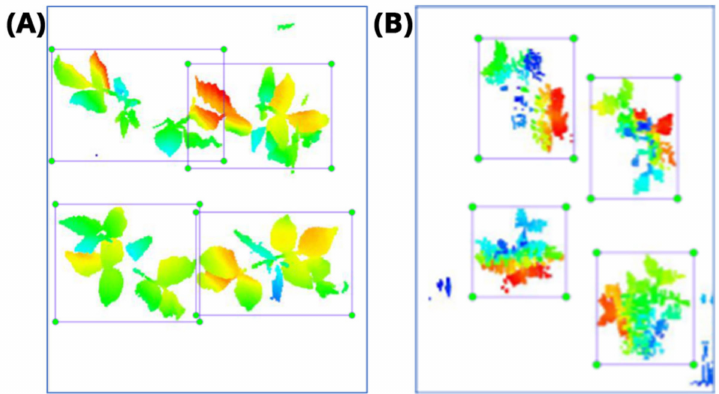
Figure 10. Samples of labeled images – mung bean ( A ), chickpea ( B ). The labeling process is carried out by drawing a box around each plant and labeling the box with the plant name. Experts manually labeled all rasterized images to generate training, validation, and testing